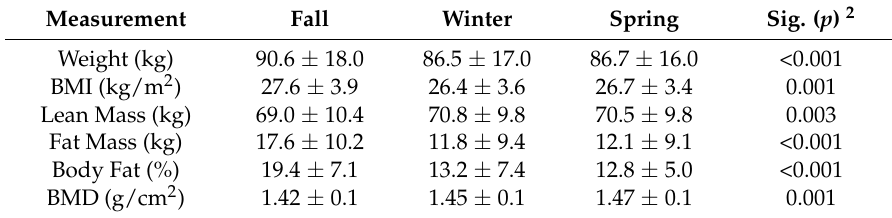
Table 2. Body composition across the academic year 1 .